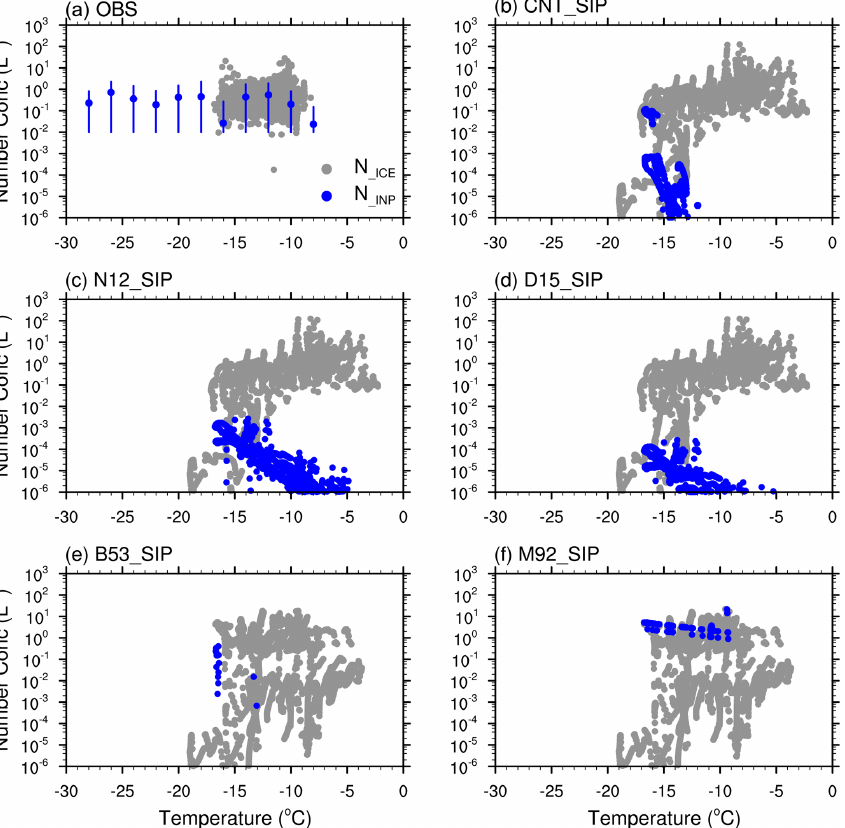
Figure 3. Comparison between INP (blue dots, in unit of L − 1 ) and ice crystal number concentrations (gray dots, in unit of L − 1 ) from (a) ob- servations, (b) CNT_SIP, (c) N12_SIP, (d) D15_SIP, (e) B53_SIP, and (f) M92_SIP experiments. Modeled ice number concentrations